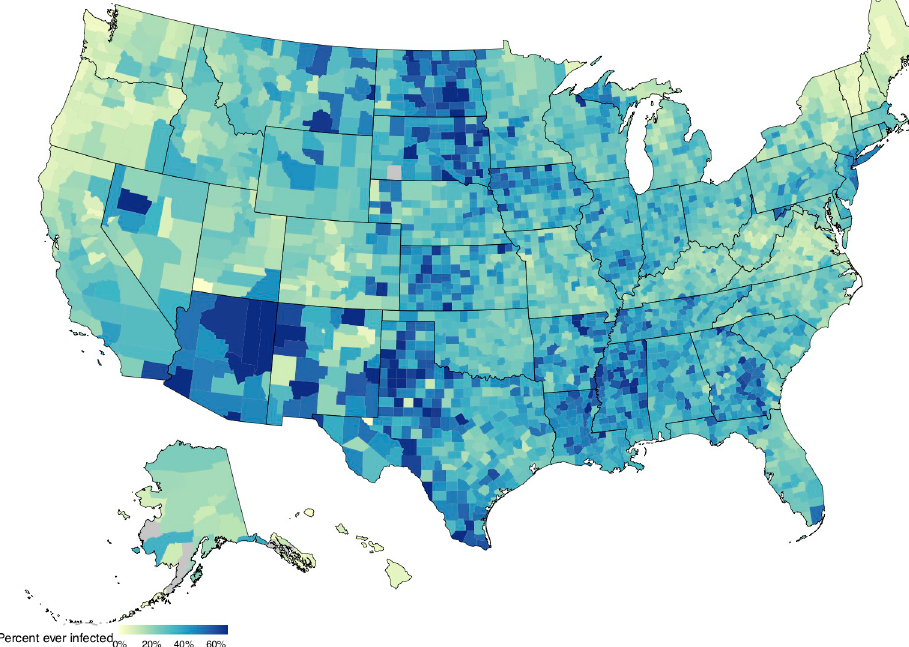
Fig 5. Percentage of the population ever-infected with SARS-CoV-2 as of January 1, 2021. Map generated using shapefiles from the alberusa package for the R programming language: